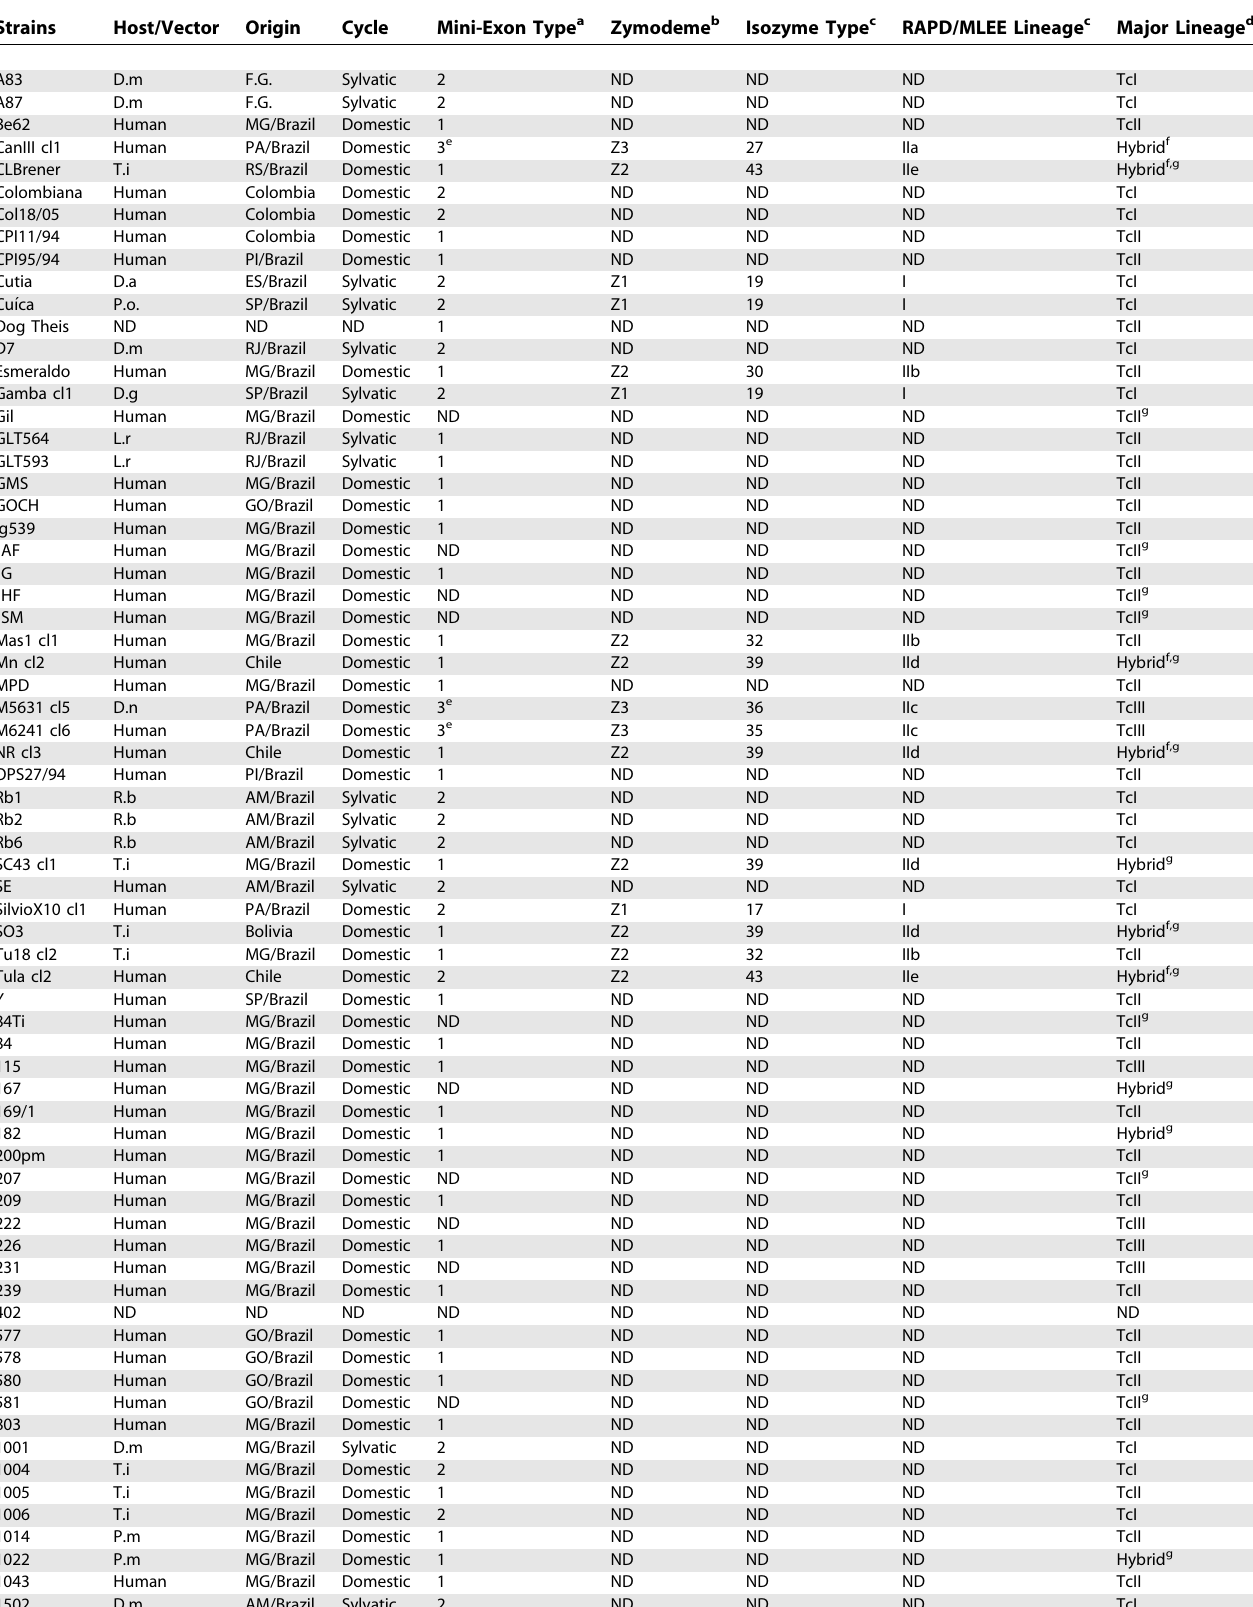
Table 1. Characteristics of T. cruzi Strains Analyzed